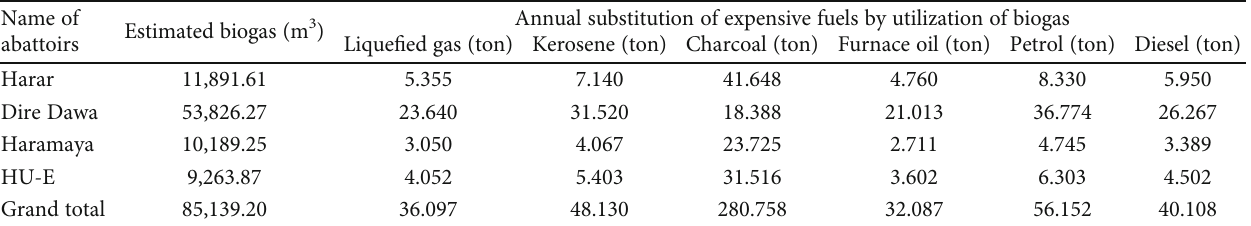
Table 5: Equivalence of estimated biogas with other fossil fuels from the selected abattoirs, 2019.